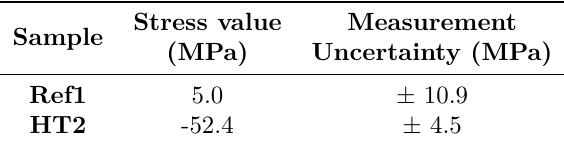
Table 3. X-Ray Diffraction